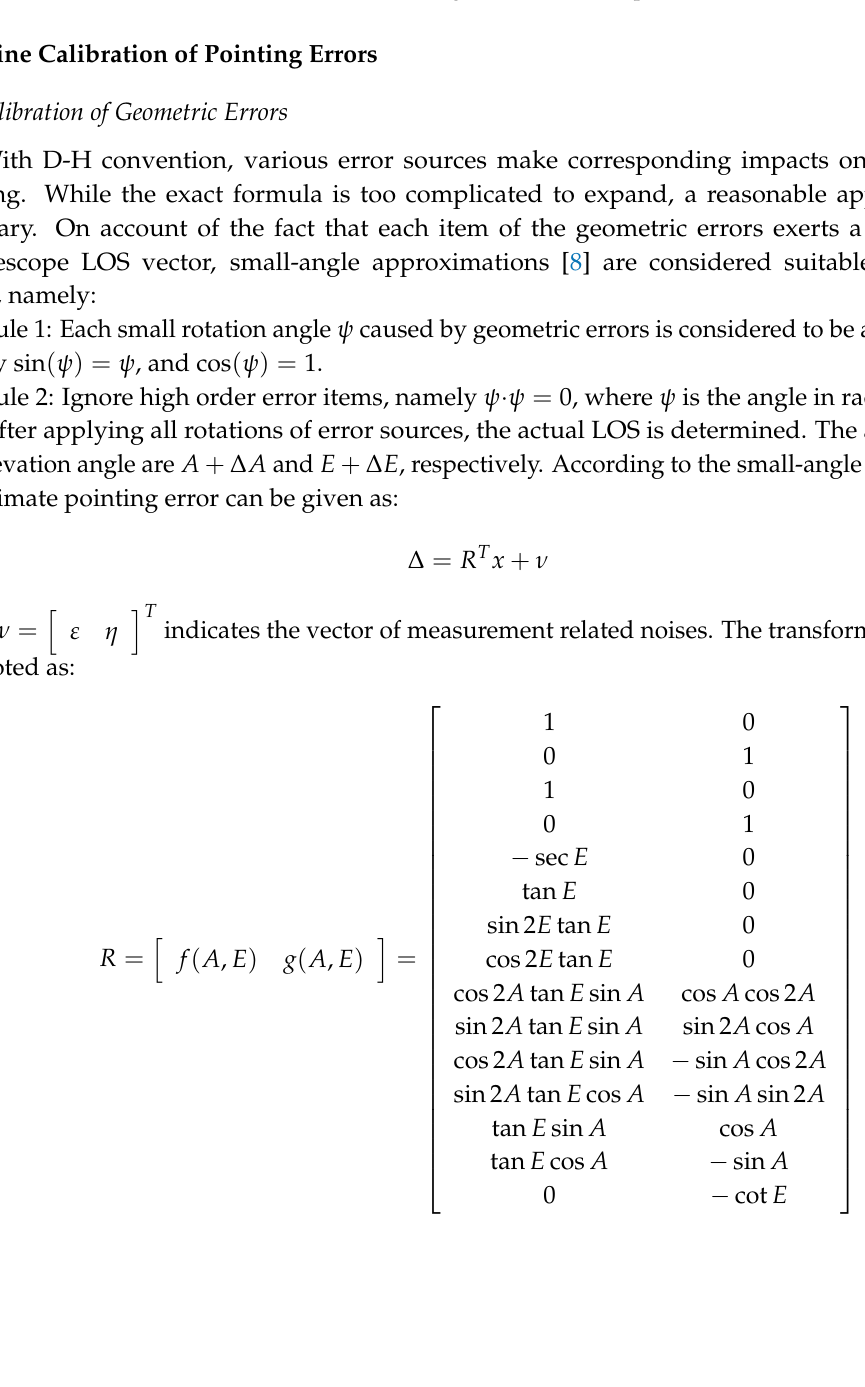
Figure 1. Pointing errors for